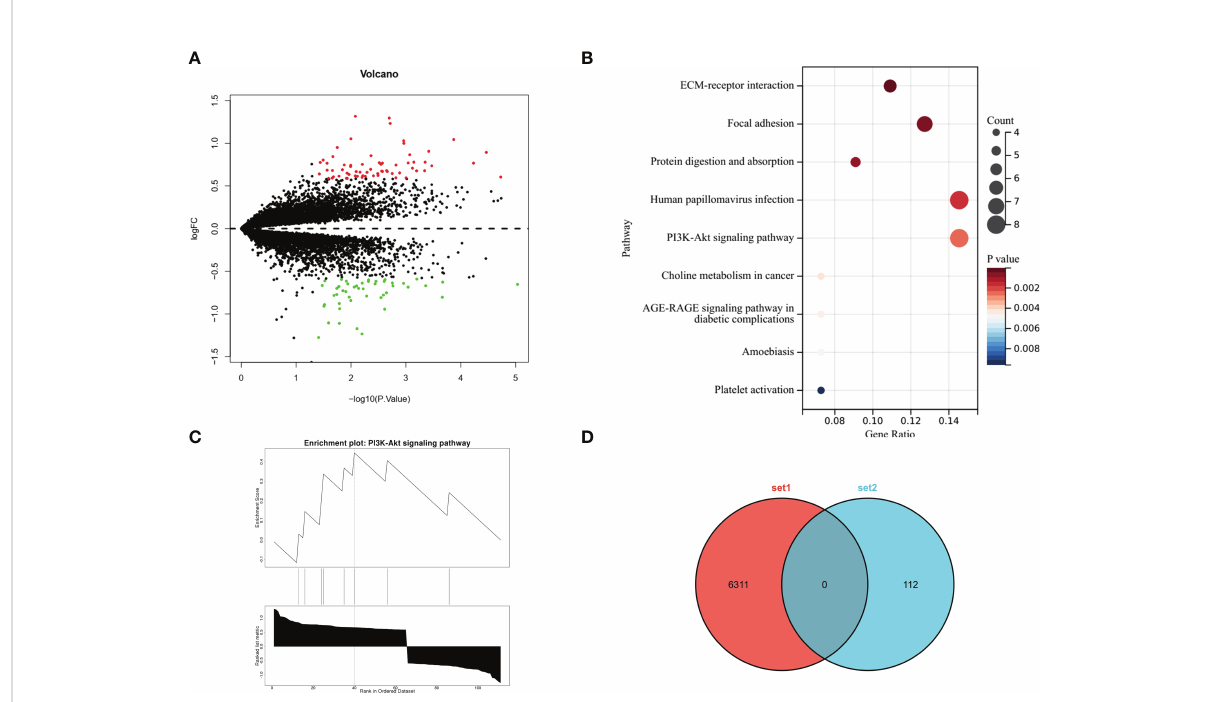
FIGURE 7 RNA sequencing results from the submandibular gland and parotid gland ACC based on the GEO database. (A) Volcano plot showing differentially expressed genes. Red dots and green dots indicate upregulated and downregulated genes, respectively, in submandibular gland ACC compared with parotid gland ACC. (B) Bubble diagram of the KEGG enrichment analysis showing the results for differentially expressed genes. The colour and size of bubbles correspond to the P value and the number of enriched genes, respectively. (C) GSEA of differentially expressed genes revealed that the PI3K signaling pathway was upregulated in ACC of the submandibular gland. (D) Venn diagram of gene set intersections: set 1 is the differentially expressed genes in the normal parotid gland and submandibular gland tissues, and set 2 is the differentially expressed genes in the parotid gland and submandibular gland ACC